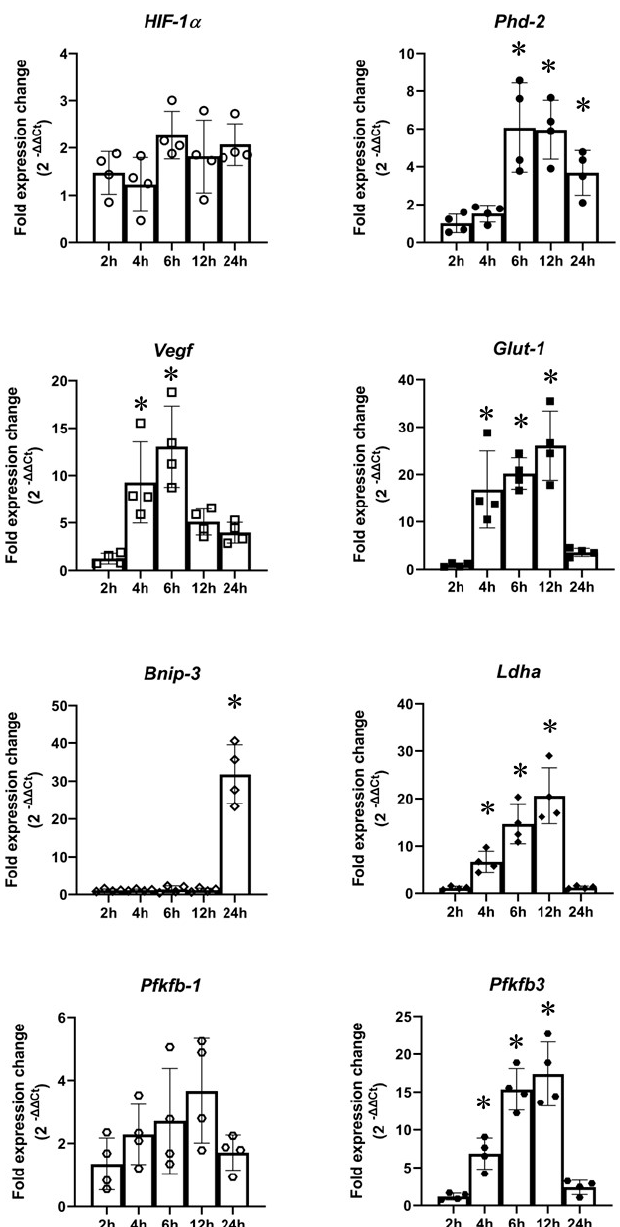
Figure 5. Gene expression in PC12 cells subjected to oxygen–glucose deprivation (OGD). There were no changes in Hif1 α and Pfkfb1 expression. There were significant increases in Phd2 expression from 6 h OGD onwards; significant changes in Vegf expression in cells subjected to 4 and 6 h OGD; significant changes in Glut1 expression in cells exposed to 4, 6, and 12 h OGD; significant changes in Bnip3 gene expression in cells exposed to 24 h OGD; significant upregulation of Ldha in cells subjected to 4, 6, and 12 h OGD; significant upregulation of Pfkfb3 in cells subjected to 4, 6, and 12 h OGD. The gene expression was measured against housekeeping gene β - actin. Error bars represent ± S.D. n = 4. * Indicates p < 0.05 against normoxia controls.